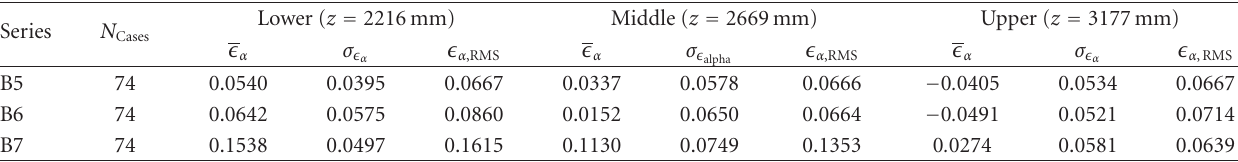
Table 7: Accuracy of steady state bundle void fraction predictions in the central 4